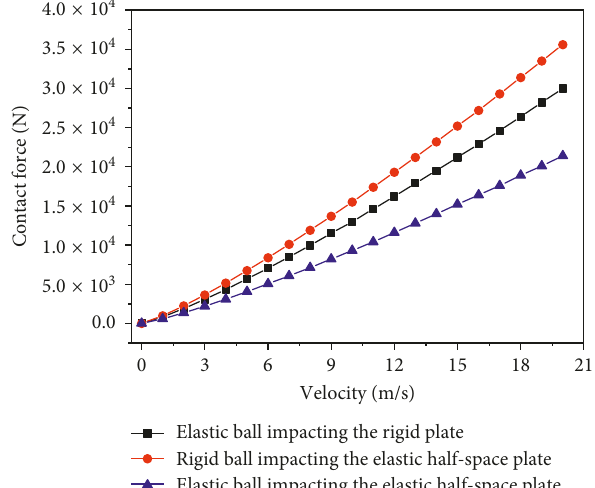
Figure 5: Maximum contact force.